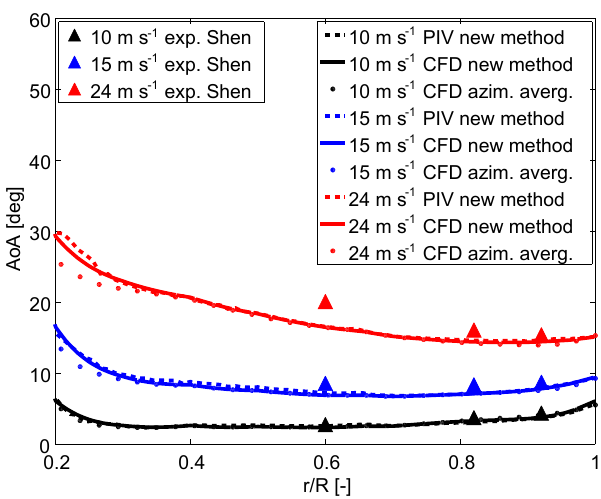
Figure 5. Angle of attack distribution along the rotor radius com- paring three different methods (new method, azimuthal averaging technique and Shen). The results from Shen have been extracted from Yang et al.